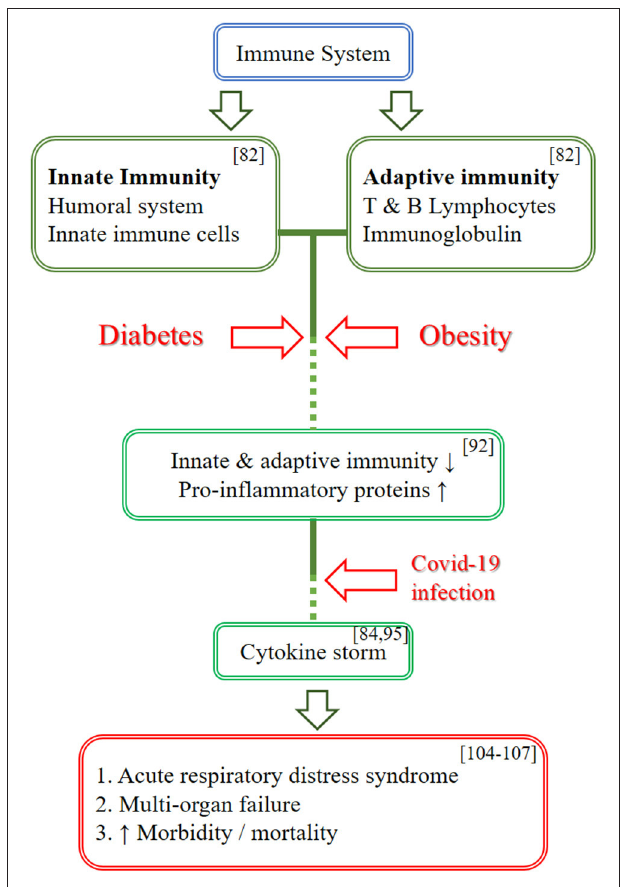
FIGURE 3 | Schematic diagram on the effects of COVID-19 infection on the immune system in individuals with diabetes mellitus/obesity. This figure illustrates the effects of COVID-19 infection on the immune system in individuals with diabetes mellitus/obesity. The immune system is divided into innate and adaptive immunity. Diabetes and obesity caused the innate and adaptive immunity to be less affective and promote hypercytokinemia state as baseline by increasing the pro-inflammatory proteins. A COVID-19 infection further increases the cytokines level and leads to cytokine storm which in turn causing more severe complication such as ARDS and multi-organ failure, thus causing the increase in morbidity and